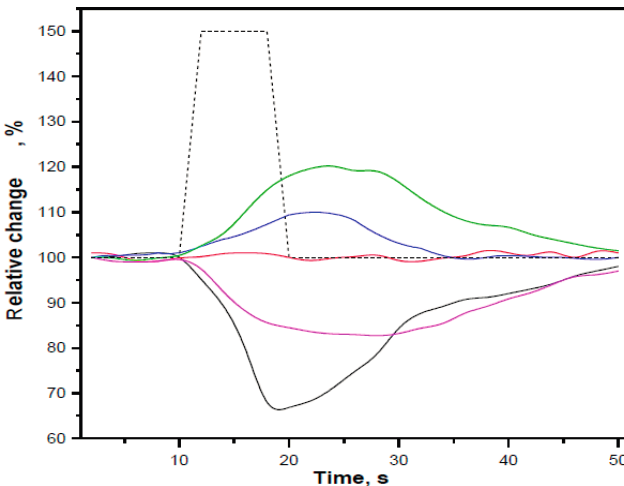
Figure 10. The temporal response of PSi MC infiltrated with MEH-PPV (Figure 2) on the pulse of TNT vapors (7 ppb, dotted line); black—the intensity of the fluorescent resonance peak; red—its spectral position; blue—resistance (R); green—capacitance (C); magenta—inductance (L). Three electrical signals recorded by the LCR meter (100 Hz) were synchronized with two optical signals (peak intensity and spectral position) through data acquisition system and LabView software